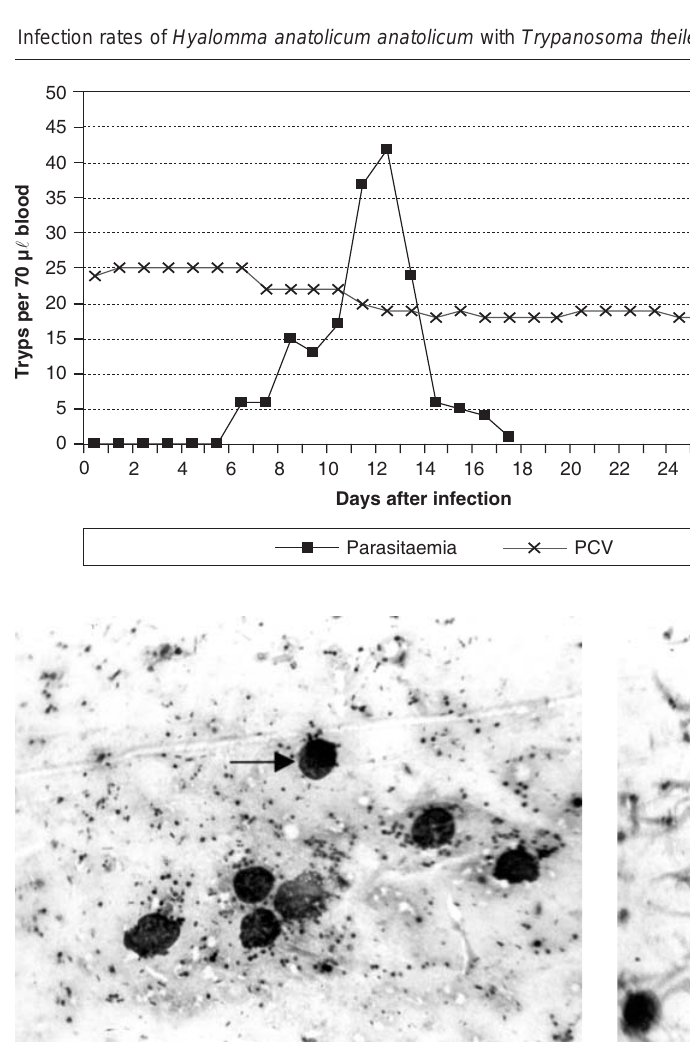
FIG. 3 Haemolymph smear from an uninfected H. a. anatoli- cum adult tick. The arrow indicates a haemocyte